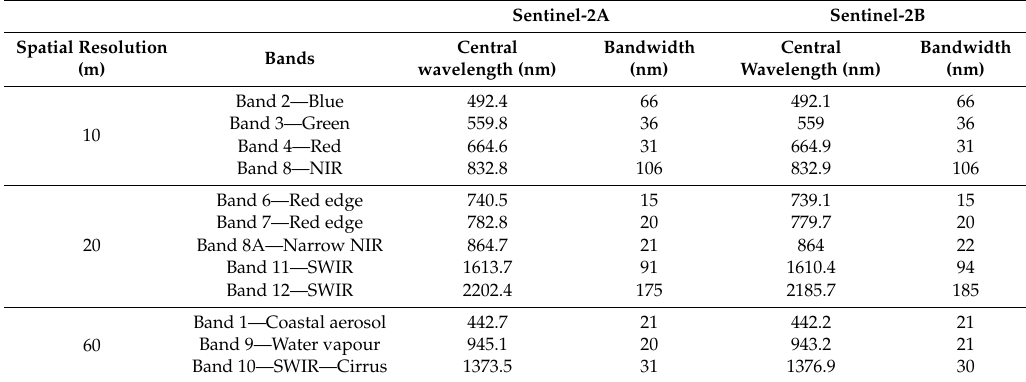
Table 2. Characteristics of ESA Sentinel-2A and -2B satellite images